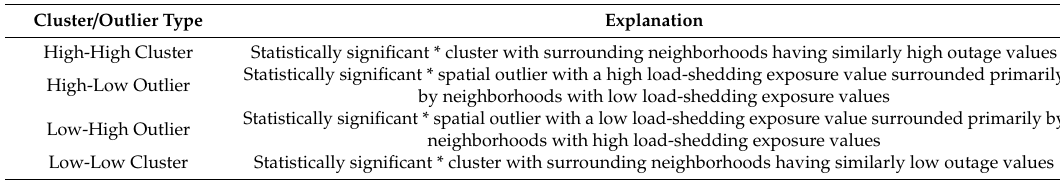
Table 3. Cluster and outlier